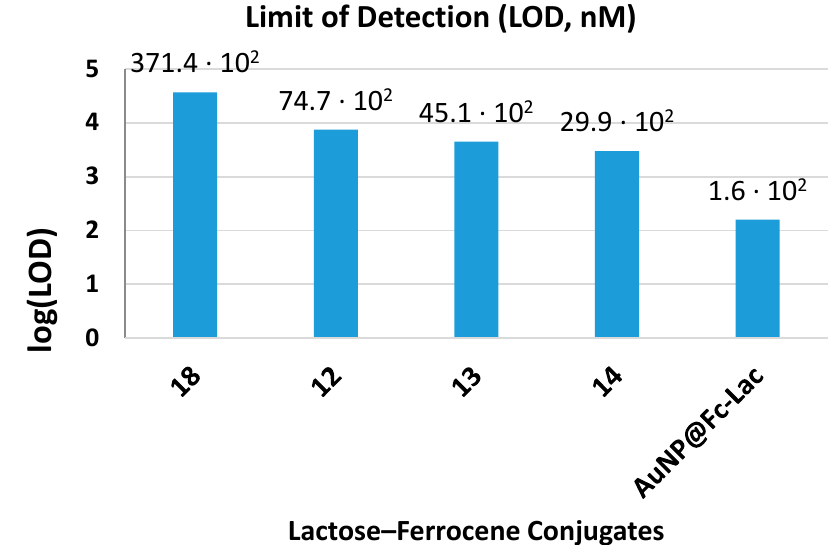
Figure 10. Limit of detection (LOD) for ferrocene–lactose conjugates 12 – 14 , 18 , and AuNP@Fc-Lac (logarithmic scale). The LOD (nM) value for each conjugate is shown over the respective bar.